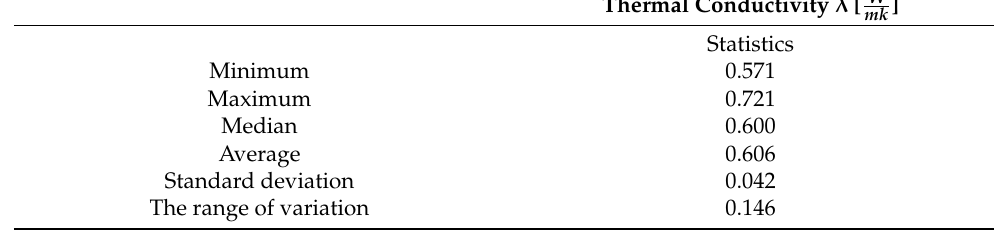
Table 5. Average thermal conductivity for basalt dust A for all samples for water − mix ratio = 0.5.